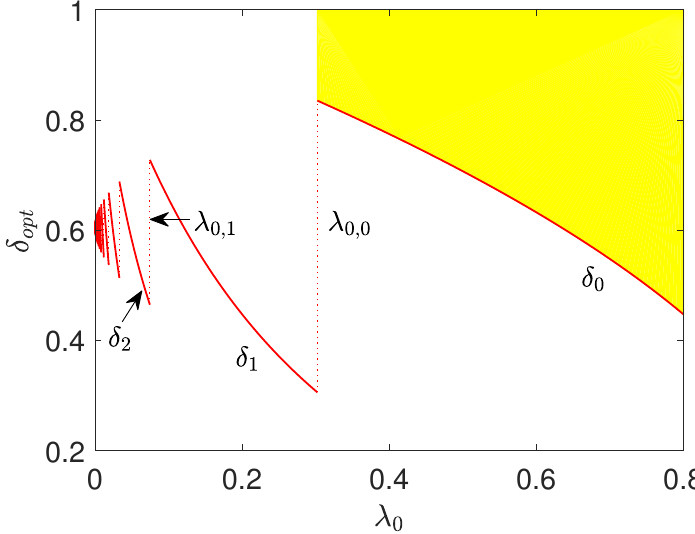
Figure 1. (Color online.) The optimal parameter δ opt as a function of the lower bound λ 0 of the fraction of target items. The red solid curves, red dotted vertical lines and the yellow (gray) area represent δ k , λ 0, k ( k ≥ 0), and the value of δ opt for λ 0,0 ≤ λ 0 ≤ 4/5,